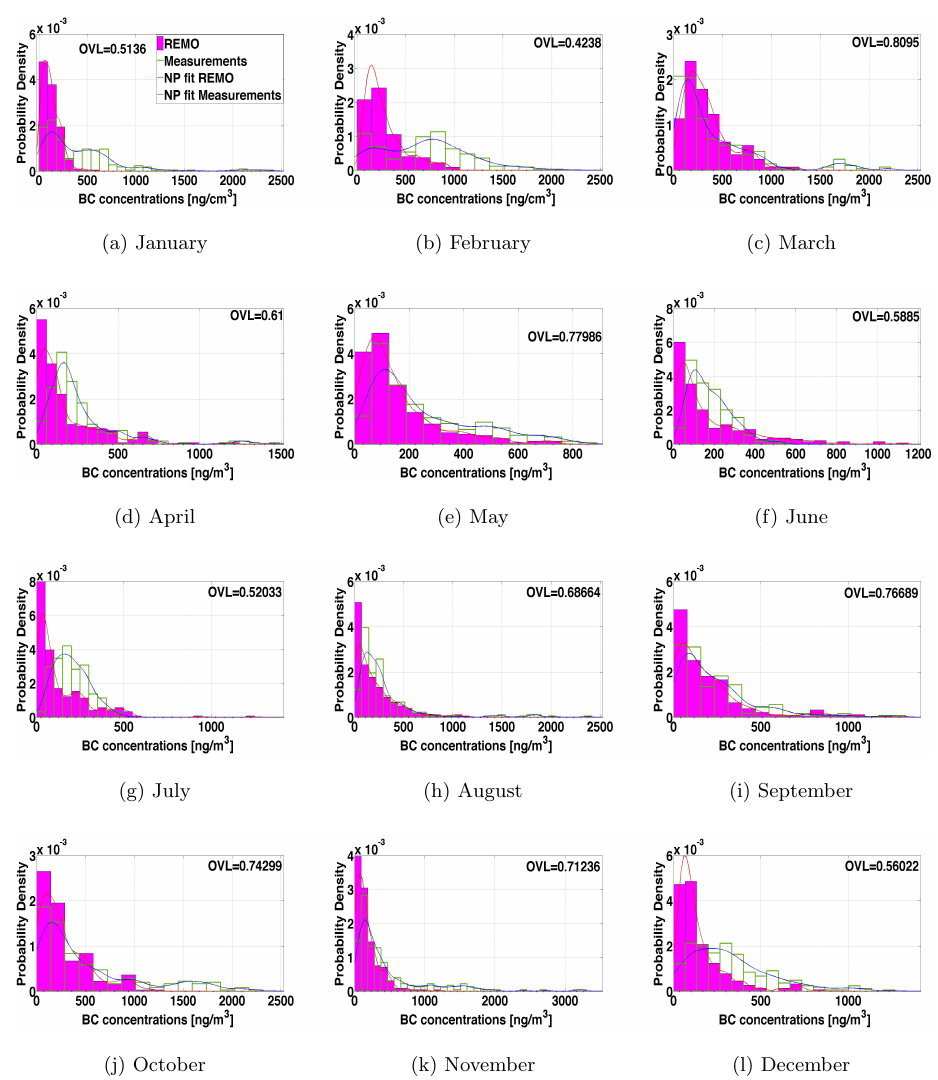
Fig. 8. Monthly histograms (pink: REMO; and green: measurements) and the probability density functions (pink: REMO; and blue: mea- surements) of the black carbon concentration (Hyyti¨al¨a 2005). The overlap coefficient (OVL) for each month is listed in the upper part of each